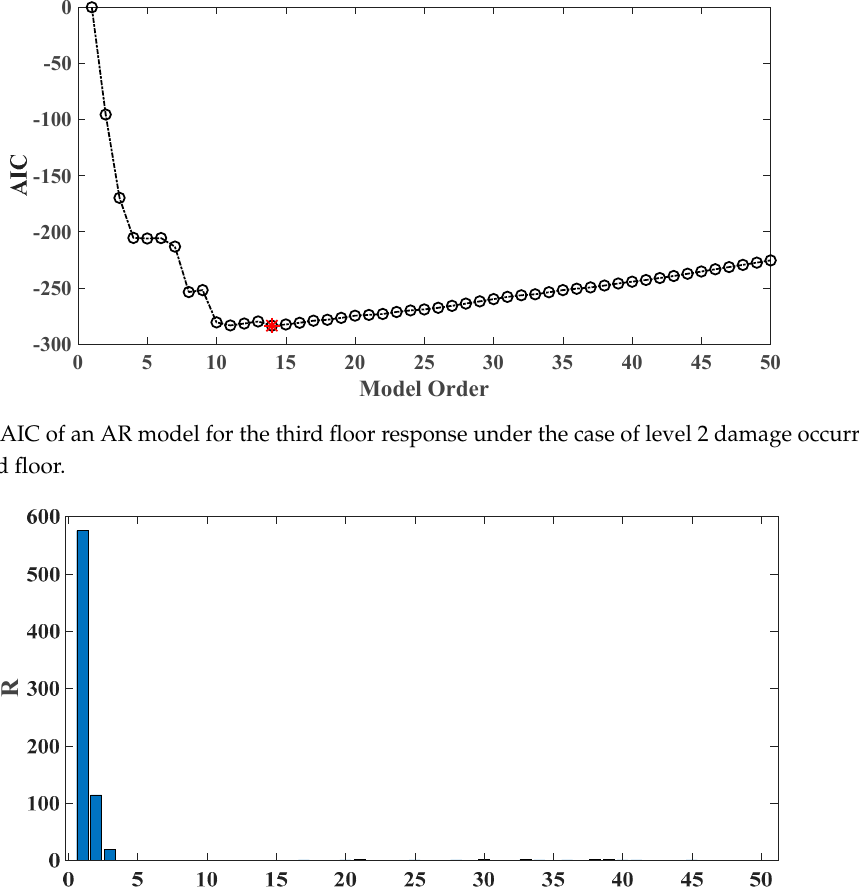
Figure 18. Damage detection results based on the OSPA distance (sine sweeping ‐ frequency